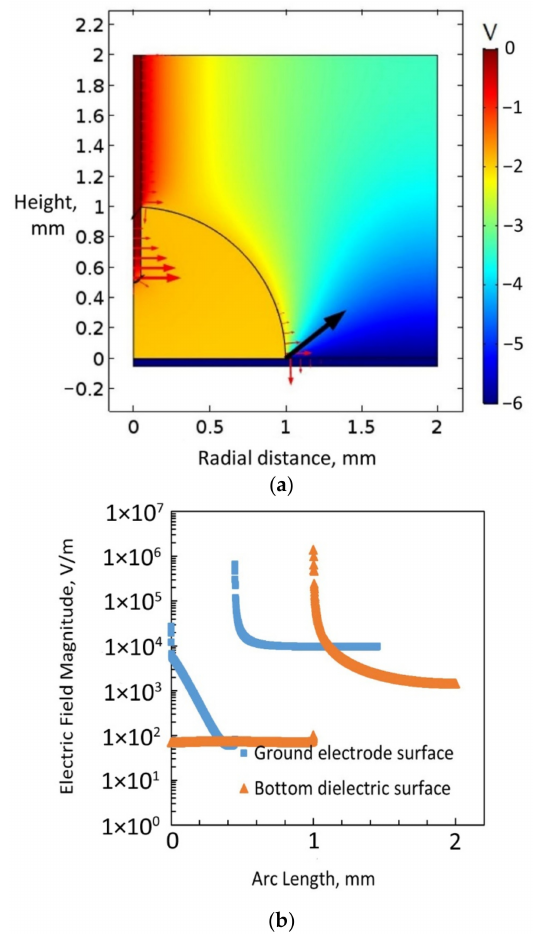
Figure 12. ( a ) Electric field simulation with water considered to be a conducting liquid, a dielectric- coated ground electrode inserted into a sessile water drop, and 6 V applied to the bottom electrode covered with a dielectric. ( b ) Electric field magnitude on the dielectric-coated ground electrode surface and bottom dielectric